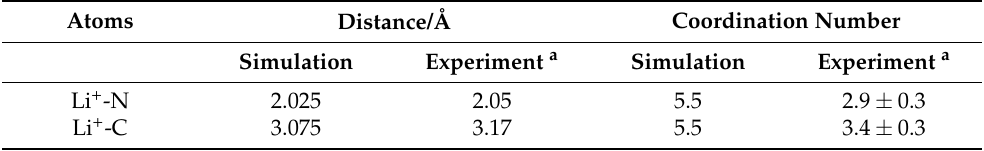
Table 4. Ion-atom distances and corresponding coordination numbers.